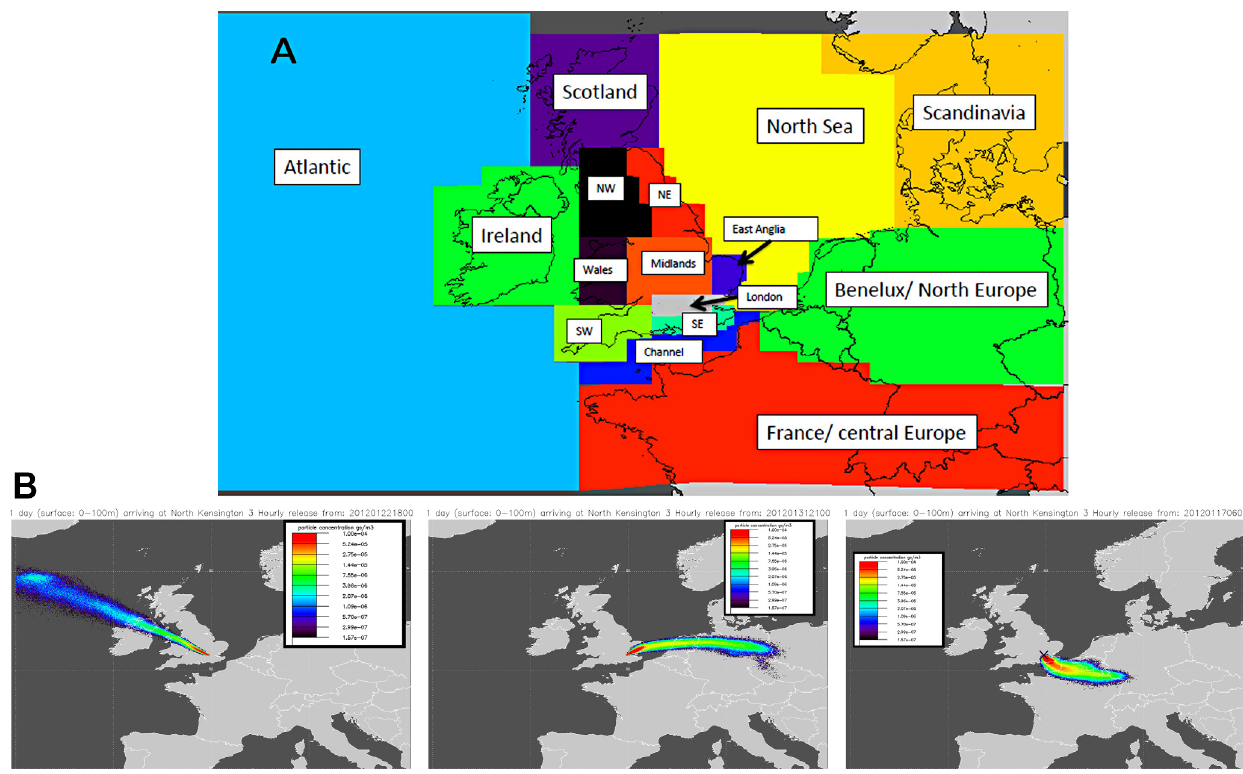
Figure 1. (a) The designated regional influences within the domain of passage for 1-day footprints in the NAME model. (b) Typical footprints for each broadly classified air mass category, the image is coloured by the particle density, with the cross marking the location of receptor. Table 1. A summary of aerosol/trace gas properties recorded during the different air mass categories, mean ± σ (standard deviation) and with median values in brackets: BC-related properties; AMS aerosol nitrate, sulfate, total organic sub-micron mass, NO x (ppb), CO (ppb) and ambient temperature